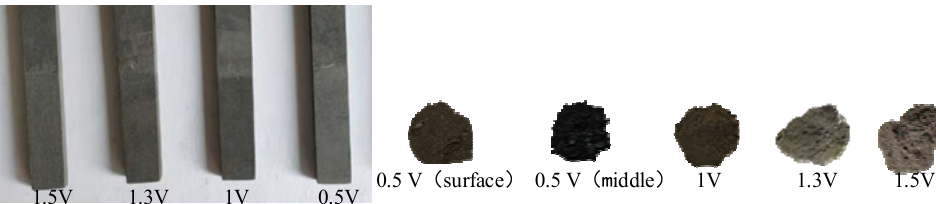
Figure 9. Images of anode ( left is graphite sheet) and cathode ( right is products after electrolysis) products of graphite rods electrolyzed at different voltages for 12 h.